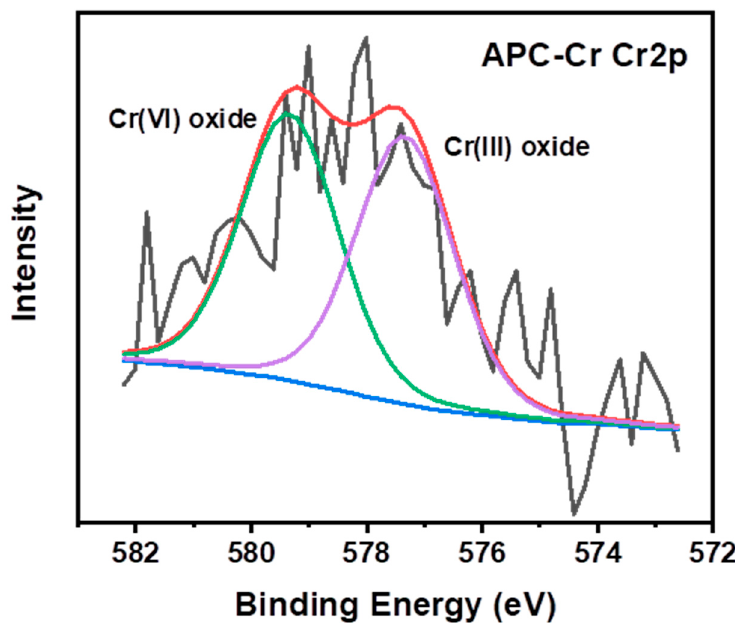
Figure 13. Deconvoluted high-resolution Cr2p spectrum of the APC sample after chromium adsorption.